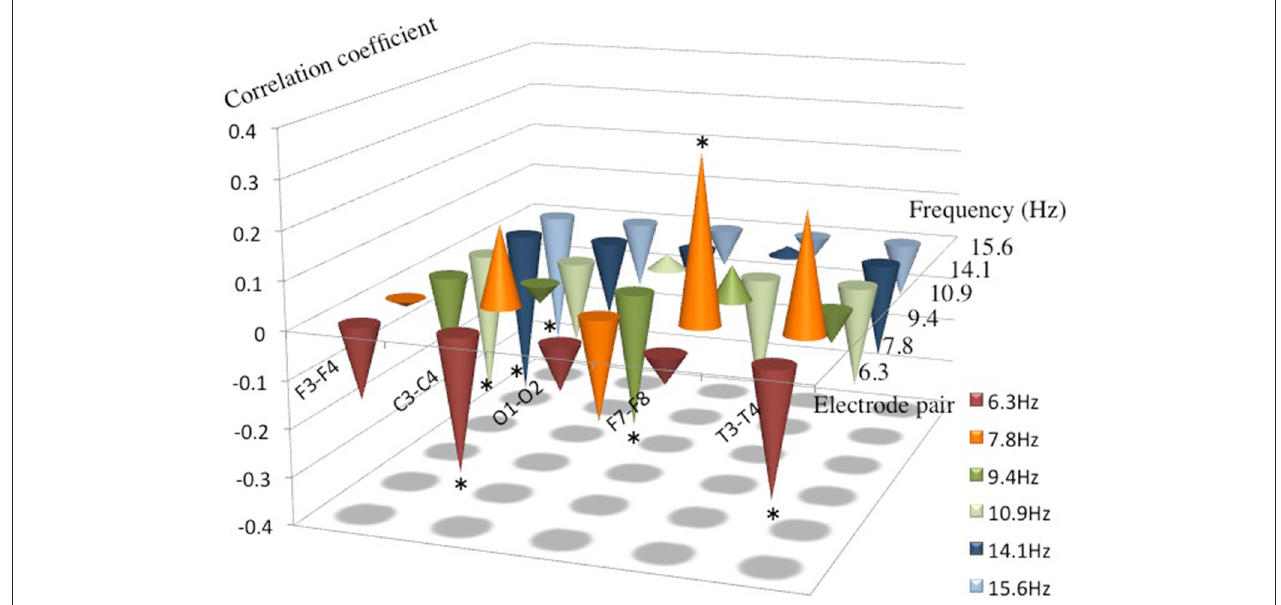
FIGURE 2 | Correlation coefficients between AI from 6.3 to 15.6Hz and the language score. Note that a positive correlation between AI and the language score was found in 7.8Hz at F7–8, and a negative correlation was found in 6.3Hz at T3–4 and C3–4, in 9.4Hz at O1–2, in 10.9Hz, 14.1Hz and in 15.6Hz at F3–4, respectively. * P <